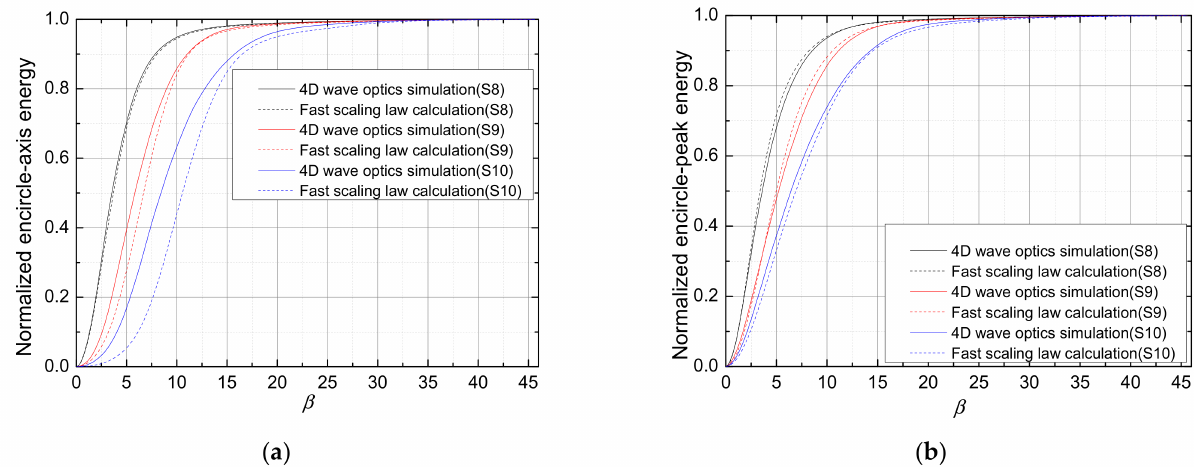
Figure 14. The change curve comparison between the fast calculation results and 4D wave optics simulation results of ( a ) Enc axis and ( b ) Enc peak with facula expansion multiple β under S8, S9, and S10 scenarios.